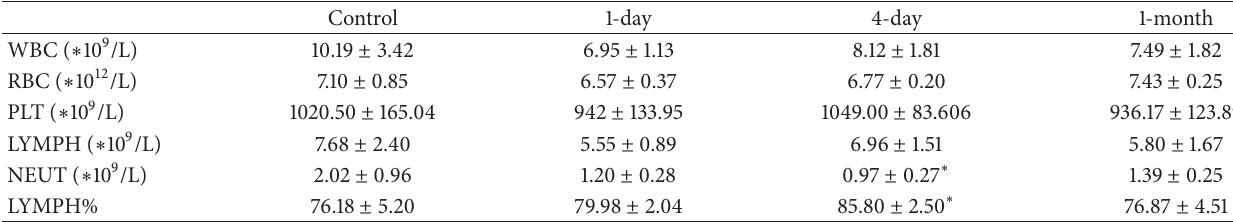
Figure 4: Detection of Luc-GFP-BMSCs in tissues at one month after injection. (a) The expression of the firefly luciferase gene was detected via RT-PCR. 𝛽 -actin was used as a loading control. Target gene expression was not found in the lungs, kidneys, or skin. 𝑛 = 5 . Representative images of at least three independent experiments. (b) Immunohistochemistry detection of GFP. The absence of GFP-positive cells verified the BLI results at one month after injection ( 𝑛 = 5 ). Table 1: Changes in the routine blood tests of the four study